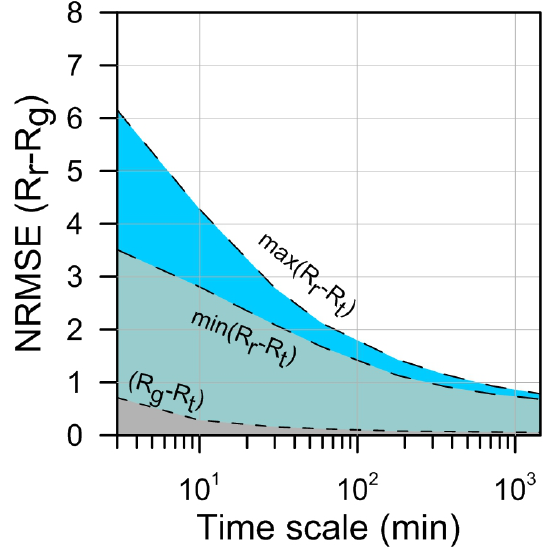
Fig. 7. Errors of radar ( R r ) vs. gauge ( R g ) rainfall for different timescales. The normalized root mean square errors of radar rain- fall ( R r ) vs. true rainfall ( R t ) were analyzed independently for 12 radar pixels. The maximum and minimum are presented by the blue sections. Gray section represents the spatial sampling error derived from the rain gauge ( R g ) vs. true areal rainfall ( R t